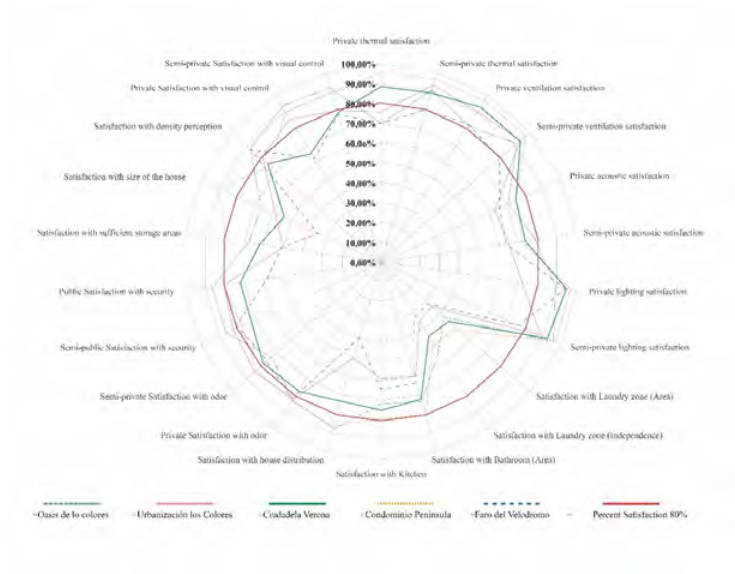
Figure 2. Perception of well-being in